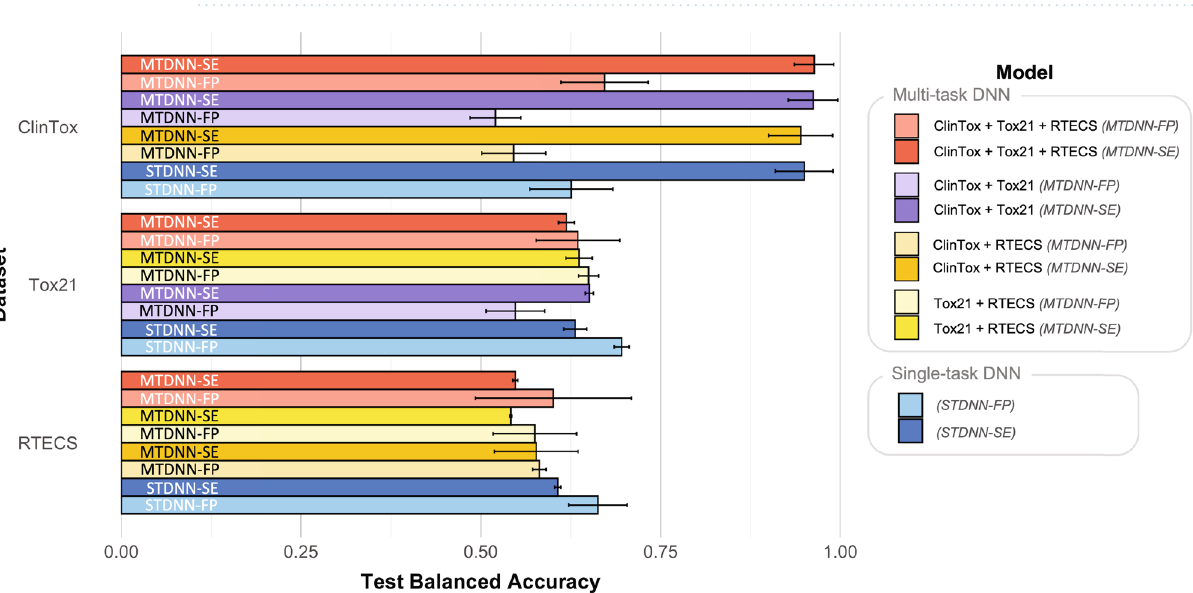
Figure 2. Test AUC-ROC values for ClinTox, Tox21, and RTECS predictions, comparing multi-task models to single-task and baseline MoleculeNet models, with SMILES embeddings and Morgan fingerprints as inputs. The best performing model on ClinTox, Tox21, and RTECS from MoleculeNet is displayed. All other MoleculeNet models are in Supplementary Fig. S2.